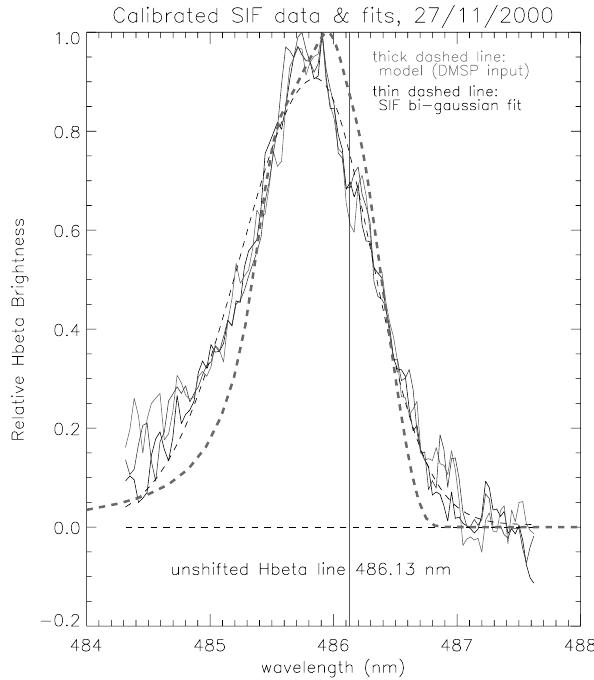
Fig. 13. Comparison of measured (solid lines) and modelled (thick dash) H β profiles. The thin dashed line is a fit to the measured